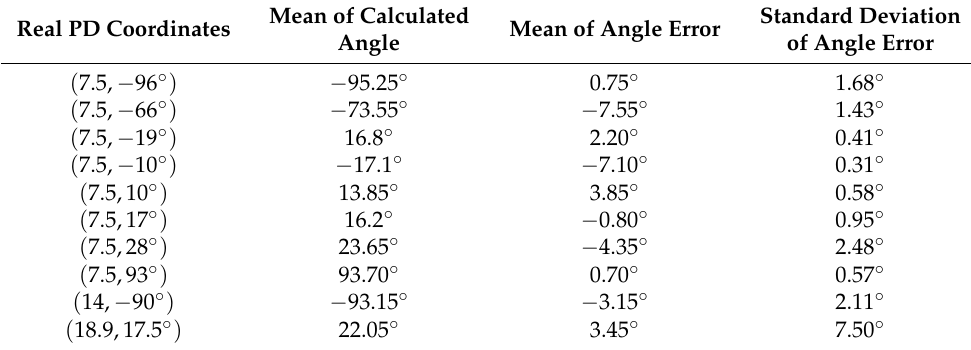
Table 5. The results of the direction of 10 sets of experimental